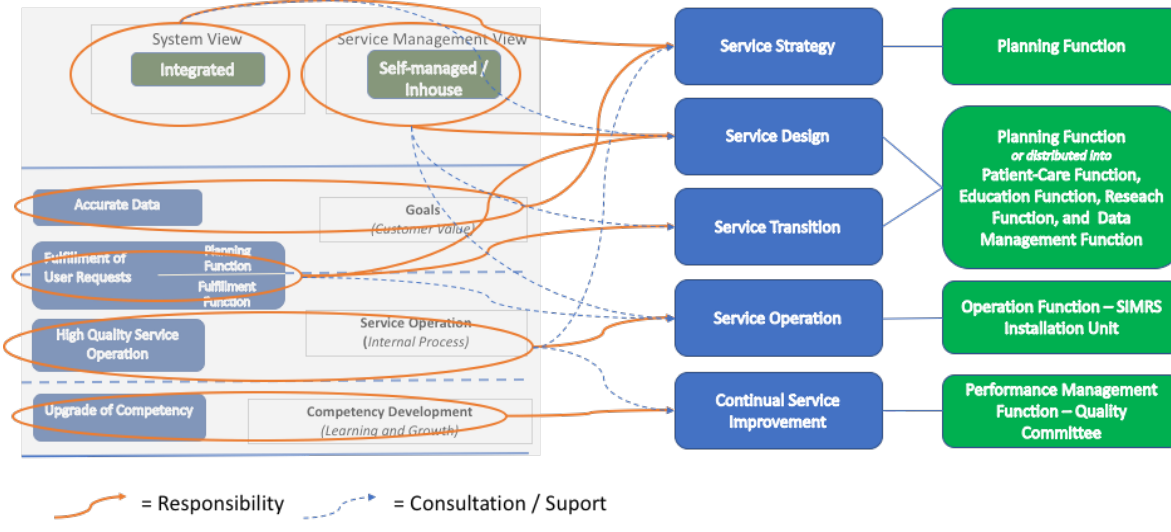
Figure 11. Mapping of baseline IT function into Service Management ITIL